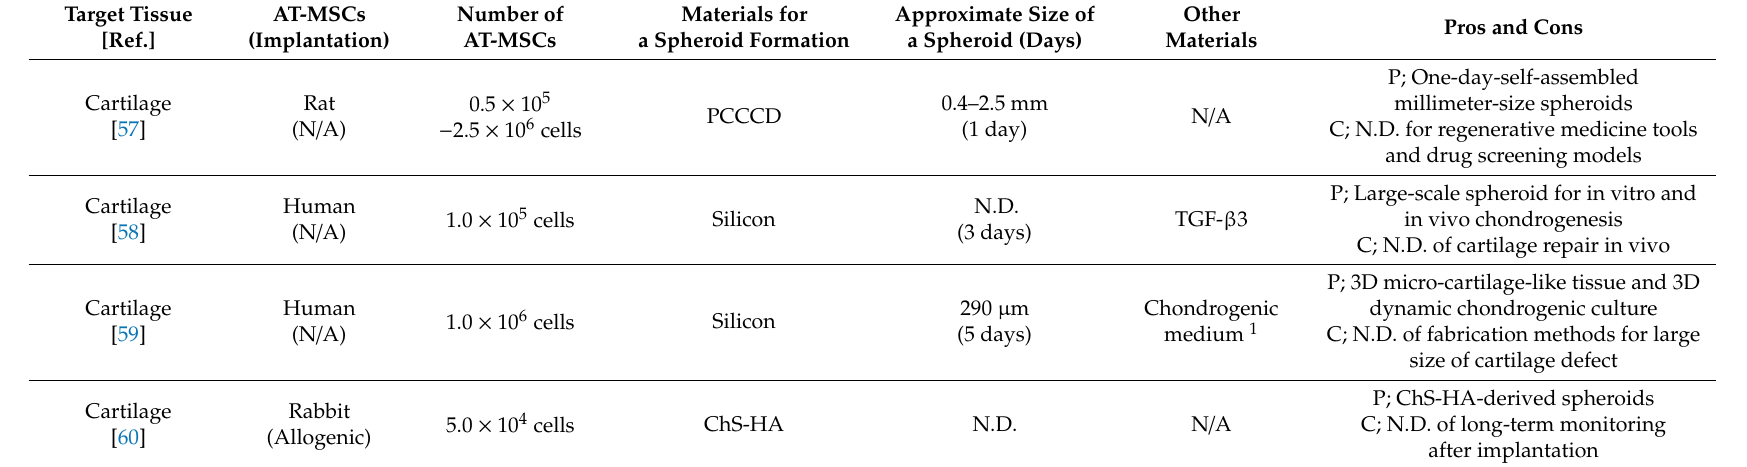
Table 2. Spheroid formation for cartilage regeneration using